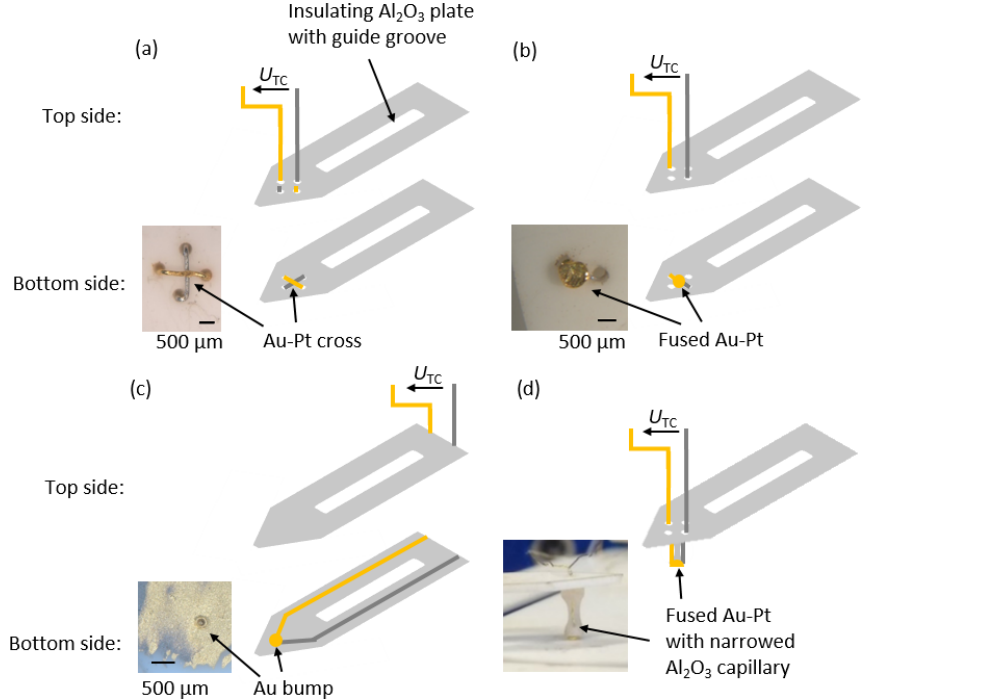
Figure 6. Schematic representation of different Au–Pt thermocouple geometries. (a) Au–Pt cross, (b) fused Au–Pt, (c) Au bump and screen- printed Au–Pt thermocouple, and (d) molten Au–Pt thermocouple with additionally narrowed Al 2 O 3 capillary.